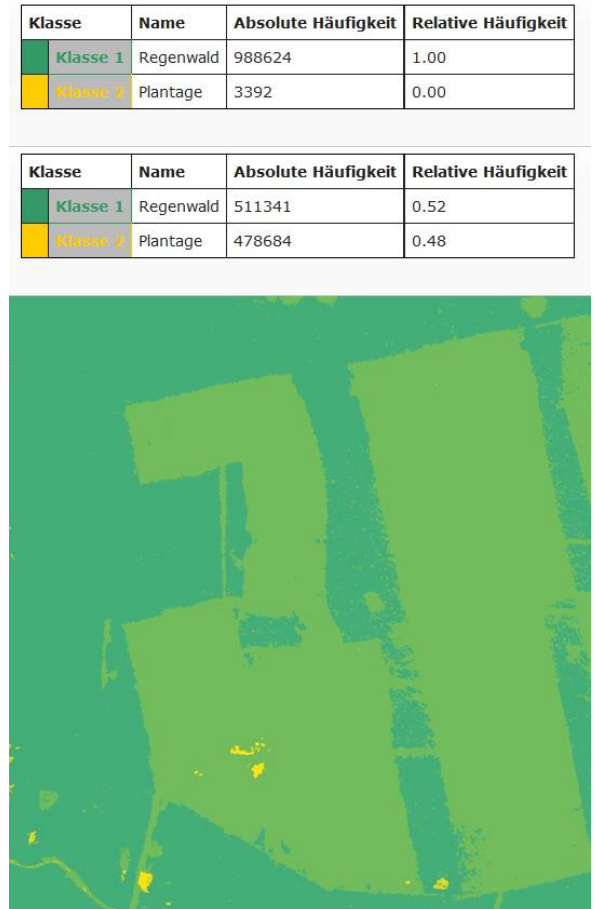
Figure 4. “BLIF” results of the change detection including absolute and relative frequency of